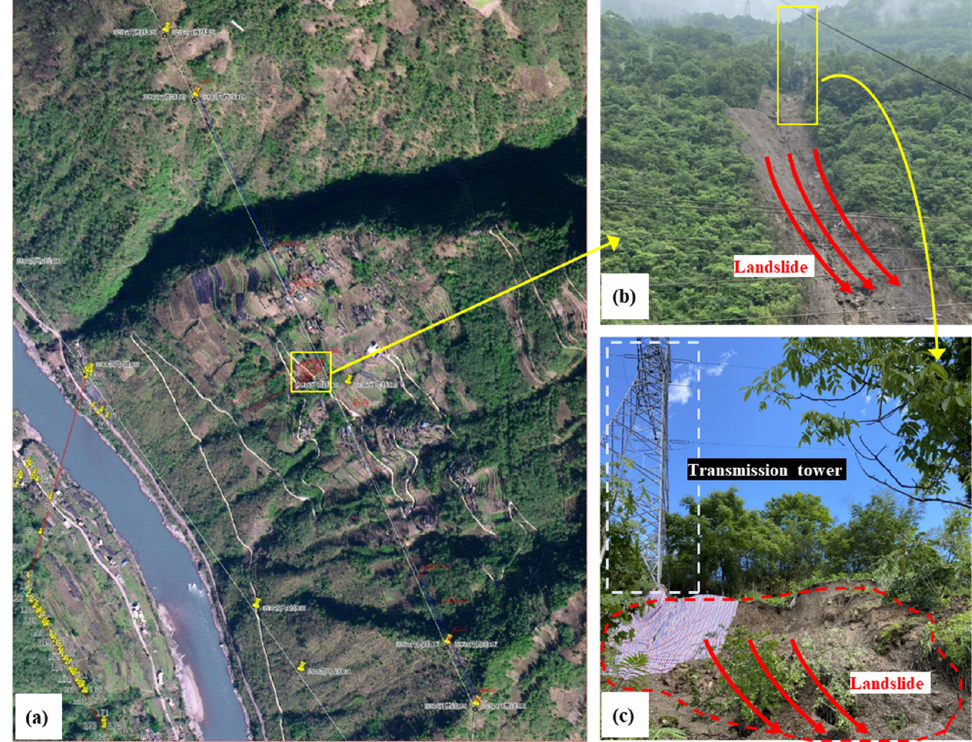
Figure 2. The landslide located at tower N18 in the Dan-Gong transmission line: ( a ) general view of the landslide, with the yellow rectangle locating the position of the tower; ( b ) landslide at the foundation of the tower; ( c ) landslide at one leg of the tower (photographed by authors).